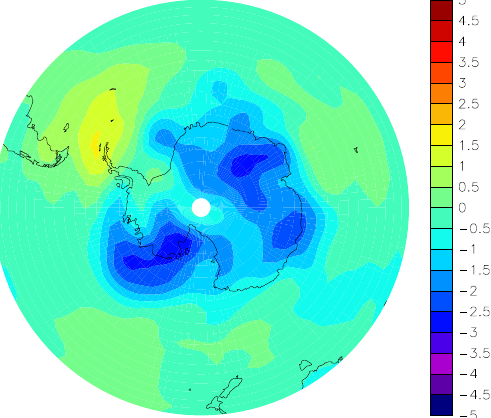
Fig. 4. Ap index versus NO x mixing ratios (nmolmol − 1 ) at 45km altitude for Northern Hemisphere winters, from the transient simu- lation. Black crosses: all available years, red stars: selected years according to Table 1.